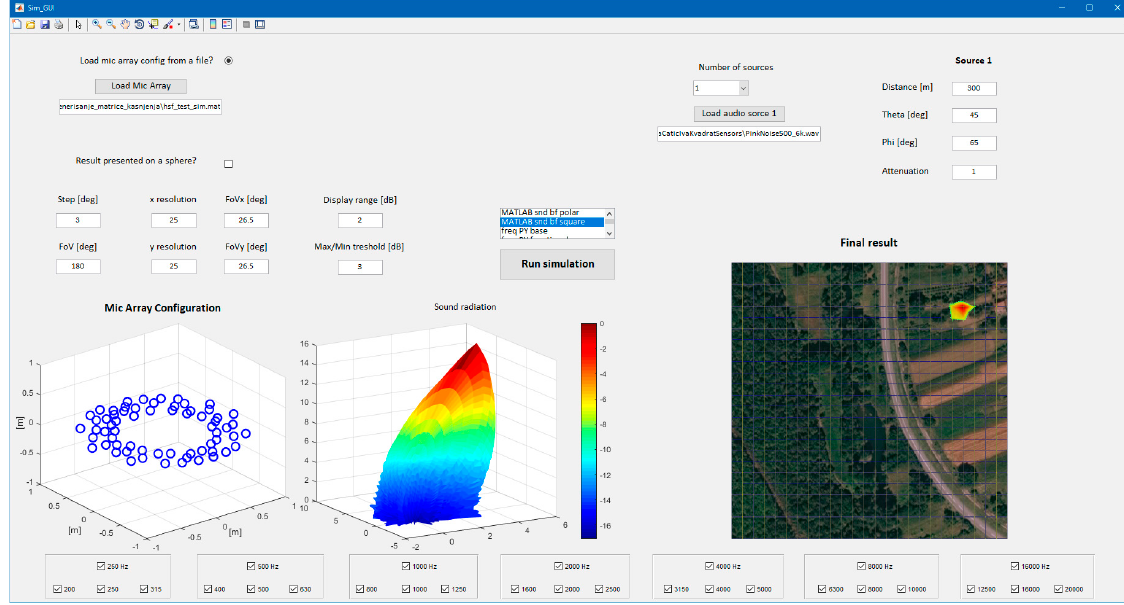
Figure 2. Simulation program